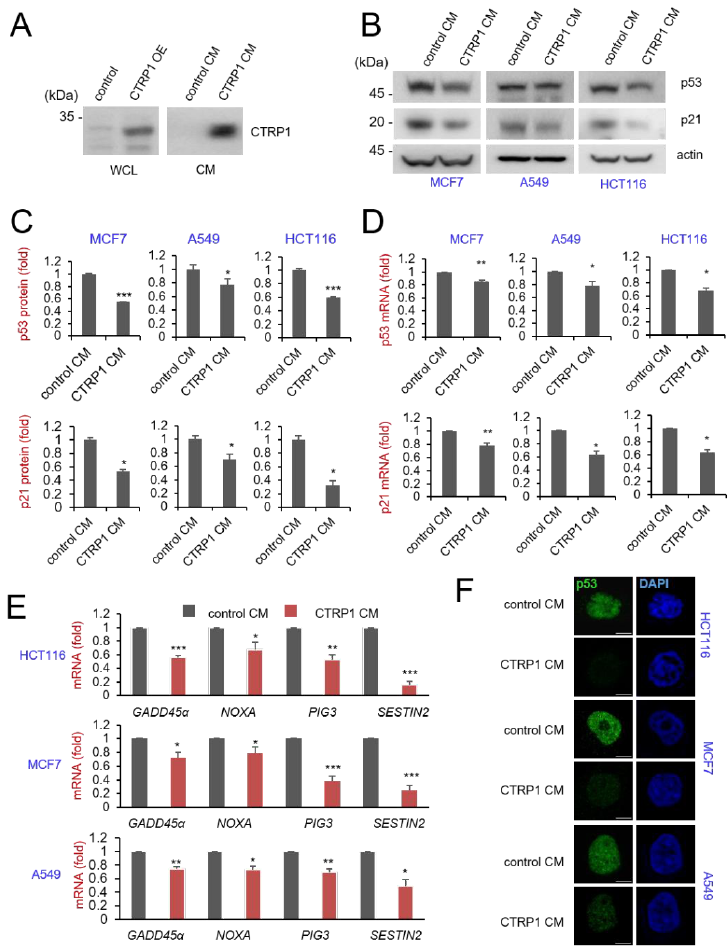
Figure 4. CTRP1 conditioned media decreased p53 and p53-dependent transcription. ( A ) CTRP1 conditioned media (CTRP1 CM) derived from CTRP1 overexpressed A549 cell lines. Lentivirus- mediated CTRP1 overexpression expresses CTRP1 protein in cell lysates (left panel). Cells were seeded and changed with CTRP1 overexpressed A549 media supernatant. At 48 h after changed, cells were harvested and probed with CTRP1 antibody (right panel). Images of the uncropped west- ern blots can be found in Figure S4. ( B ) CTRP1 CM decreases p53 and p21 protein levels. HCT116 cells, MCF cells, and A549 cells were incubated with either control CM or CTRP1 CM. At 48 h after the incubation, cells were harvested and probed with the indicated antibodies. Images of the un- cropped western blots can be found in Figure S5. ( C ) The level of p53 and p21 protein in each cell lines was quantified and depicted in the graph (* p < 0.05, ** p < 0.01, *** p < 0.005, below panel). ( D ) The level of p53 and p21 mRNA were quantified and depicted in the graph (* p < 0.05, ** p < 0.01, *** p < 0.005, below panel). ( E ) CTRP1 CM decreases p53 and p53-dependent transcripts. The expression level of p53, p21, GADD45α, NOXA, PIG3 , and SESN2 mRNAs was measured using quantitative RT-PCR in HCT116 cells, MCF7 A549 cells. ( F ) CTRP1 CM decreases p53 protein expression level. The HCT116 cells, MCF cells, and A549 were fixed and immunostained with anti-p53 (green). Scale bar, 10 μm.